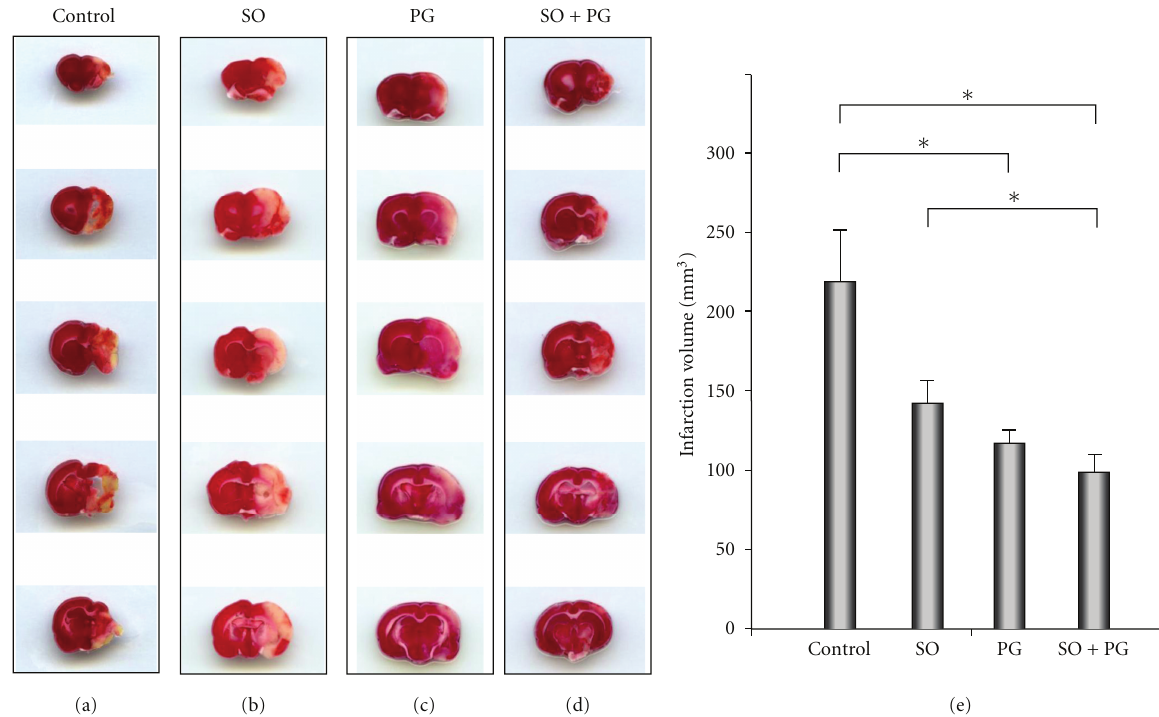
Figure 1: These figures show the cerebral ischemic area at 15 days after MCAO rats. ((a) control group: Con, (b) Sodium Ozagrel group: SO, (c) Panax ginseng group: PG, (d) Sodium Ozagrel plus Panax ginseng group: SO + PG). The ischemic areas were identified by 2% 2-3-5-triphenylterazolium staining; nonstained areas are ischemic areas. (e) Calculated infarct volumes based on 6 sequential brain slices. Treatment with PG or SO + PG group showed significant reduction in infarct volume, and SO + PG group showed much reduction of infarct volume compared to other groups. ∗ P < .